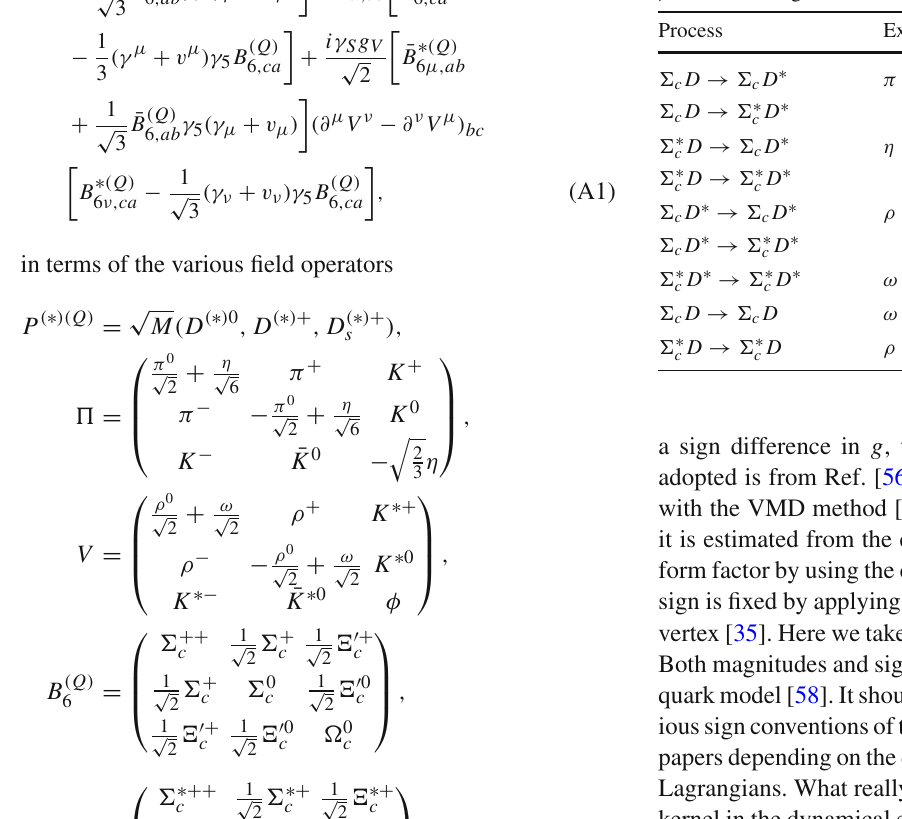
Table 4 The combined coupling factors and isospin factors for all the involved processes. It implies the first seven reactions contains the π , η , ρ and ω exchange, while the last two only have the ρ and ω exchange